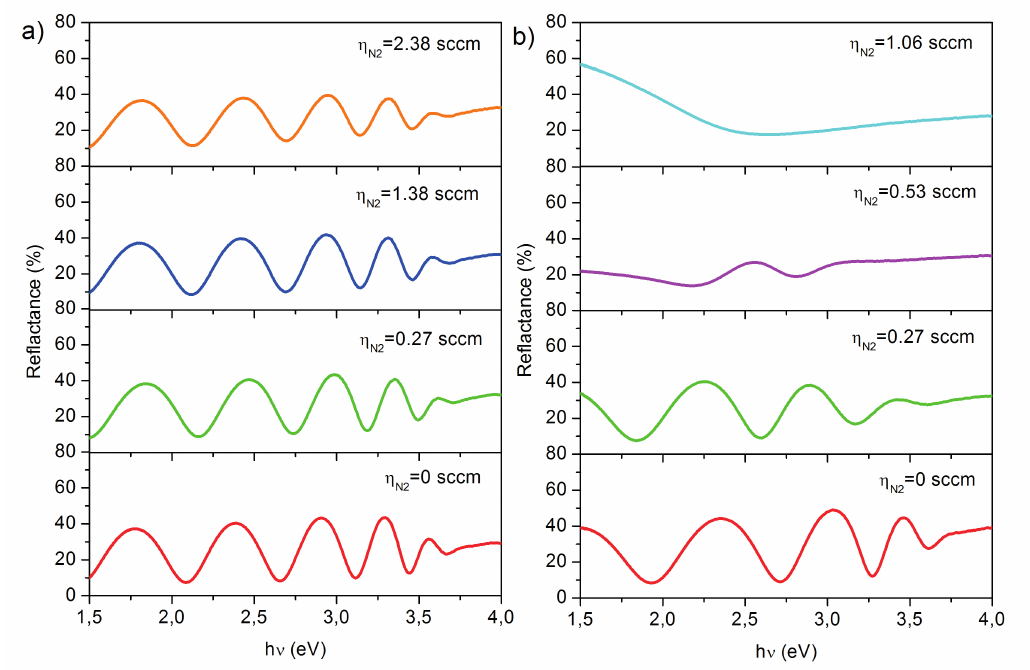
:N (I/I =0.13) and (b) non-stoichiometric TiO 2 0